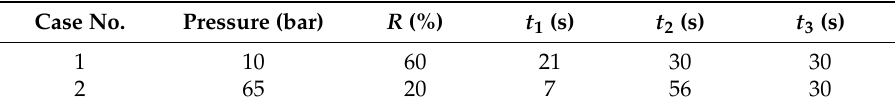
Table 2. Experimental conditions of the investigated test cases.